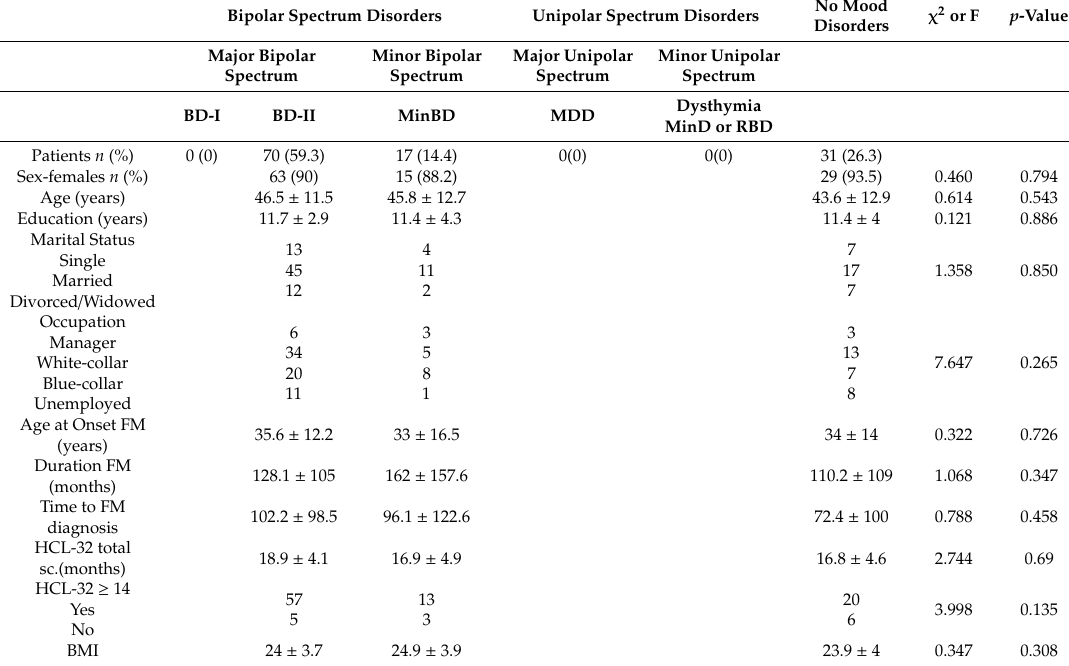
Table 1. Mood disorders diagnosis, demographic, and clinical